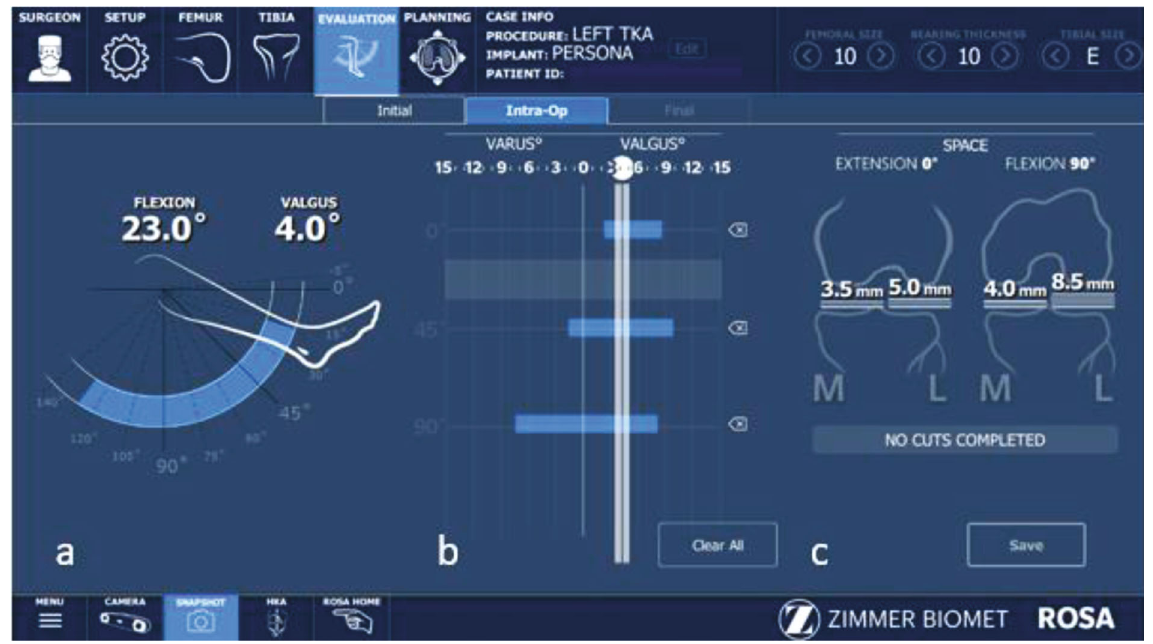
Figure 19: Intraoperative evaluation of Case 5 including (a) ROM, (b) alignment, and (c) joint space